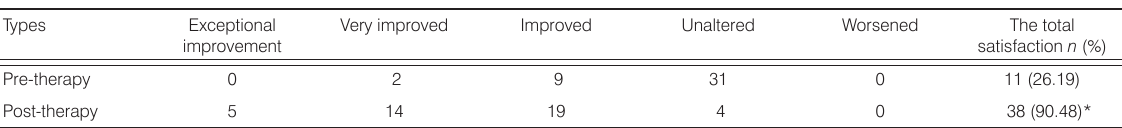
Table 3. Rating results comparison of the patients’ guardians satisfaction before and after the